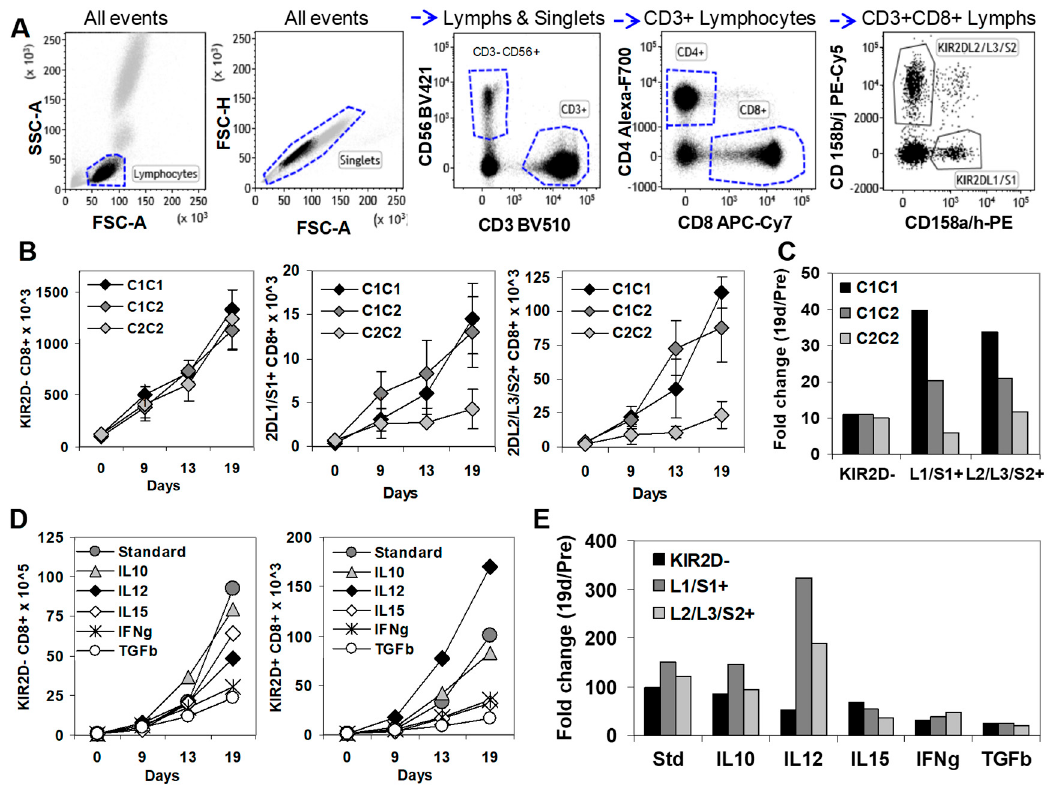
Figure 4. In vitro expansion of KIR2D − and KIR2D + CD8 + T cells. ( A ) Immunophenotype analysis of KIR2D − and KIR2D + CD8 + T cells. Left to right, FSC / SSC dot plot showing all events to select lymphocytes, FSC-A / FSC-H dot plot showing all events to select singlets, CD3 / CD56 dot plot showing singlet / lymphocytes to select CD3 + T cells and CD3 − CD56 + NK cells, CD4 / CD8 dot plot showing CD3 + lymphocytes to select CD4 + and CD8 + T cell subsets, and CD158ah / CD158bj dot plot showing CD8 + lymphocytes to select CD158ah (KIR2DL1 / S1 + ) and CD158bj (KIR2DL2 / L3 / S2 + ) CD8 + T cells. ( B ) In vitro expansion of KIR2D − and KIR2D + CD8 + T cell subsets from peripheral blood mononuclear cells (PBMC) of C1C1, C1C2, and C2C2 healthy donors in the presence of IL-2 (40 µ g / mL), 0.5 × 10 6 100 Gy irradiated JY cell line, and 5 × 10 6 25 Gy irradiated PBMC from the same C1C2 healthy donor, at days 0, 9, 13, and 19 (standard conditions). These experiments were repeated 3 times. ( C ) Fold increase at day 19 of CD8 + T cell subsets in C1C1, C1C2, and C2C2 donors. ( D ) In vitro expansion of KIR2DL1 / S1 + and KIR2DL2 / L3 / S2 + CD8 + T cell subsets from PBMC of a C1C2 donor in the same conditions as in B, but IL-10 (20 ng / mL), IL-12 (5 ng / mL), IL-15 (10 ng / mL), IFN γ (50 ng / mL), or TGF β (1 ng / mL) were added at day 0. ( E ) Fold change at day 19 of CD8 + T cell subsets after the addition of different cytokines to the standard expansion protocol.